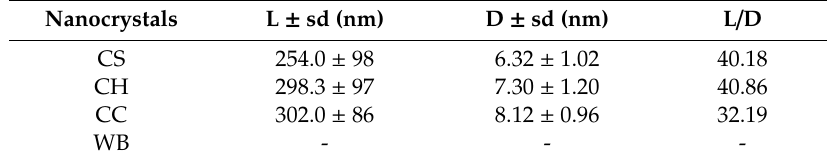
Figure 2. Phenomenon of birefringence observed through a polarized lens after dispersion of cellulose nanocrystals extracted from corncob (CC). nanocrystals extracted from corncob (CC). Table 5. Size of the nanocrystals of di ff erent lignocellulosic sources (mean ± standard